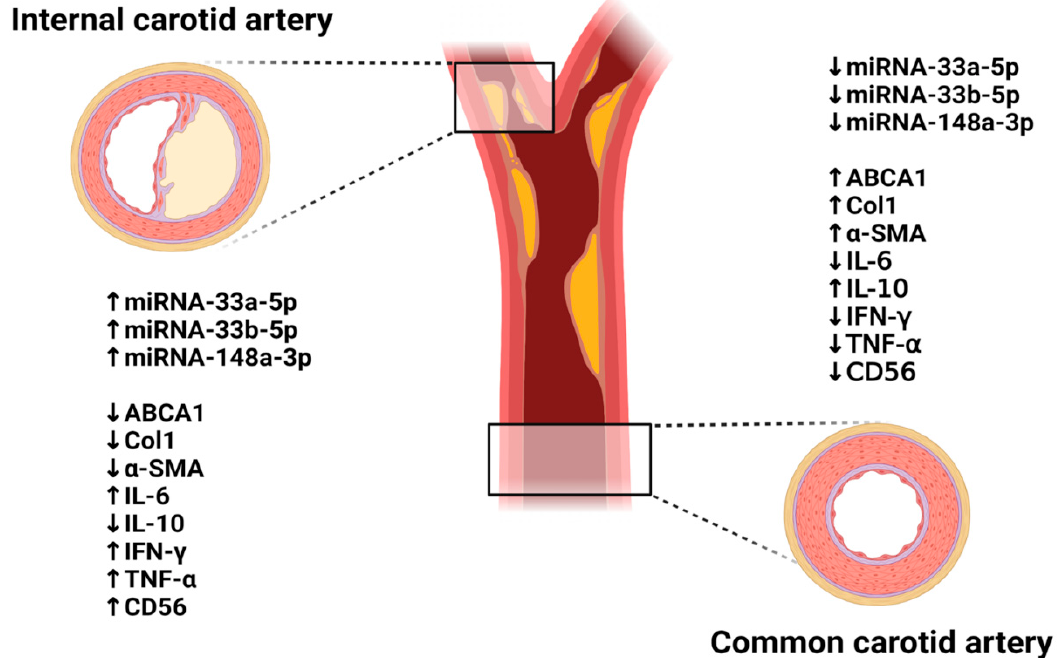
Figure 10. Summary diagram of the global hypothesis in this study.